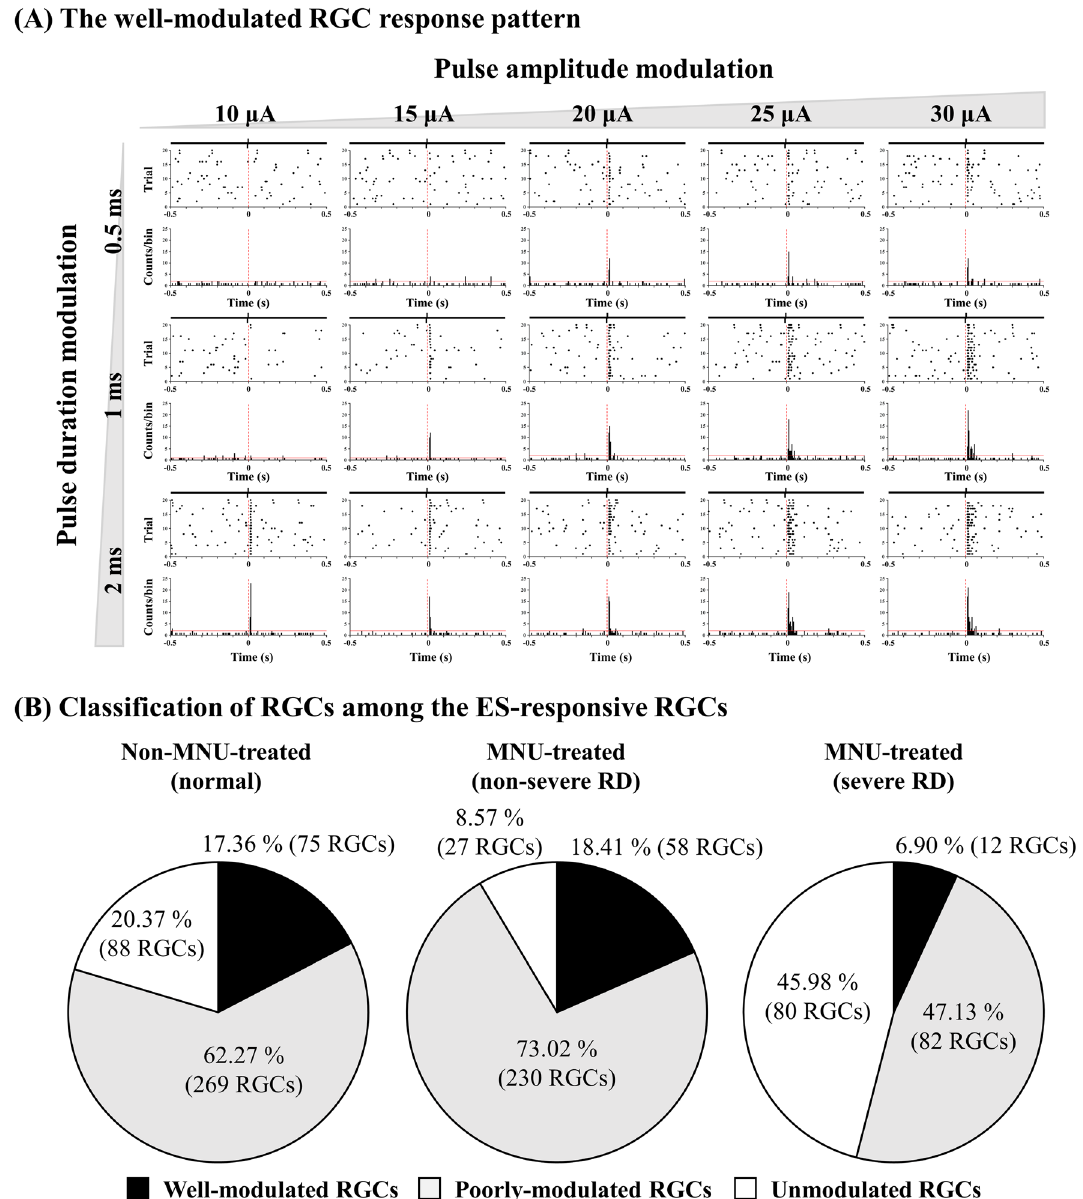
Figure 3. Response pattern of RGCs to electrical pulse amplitude and duration modulation. ( A ) A typical well-modulated RGC response pattern in raster presentation (upper row) and post-stimulus time as histograms (PSTH, lower row). The pulse amplitude of electrical stimulation was modulated into five steps from 10 to 30 μA. With each pulse amplitude, the pulse duration of electrical stimulation was also modulated into three steps from 0.5 to 2 ms. The time bin of PSTH was 20 ms. The red vertical dashed lines in the raster plot and PSTH indicate electrical stimulus onset. The red horizontal lines in the PSTH indicate 99% confidence level. ( B ) RGCs classified as well-modulated, poorly modulated, and unmodulated based on their response pattern to electrical stimulation